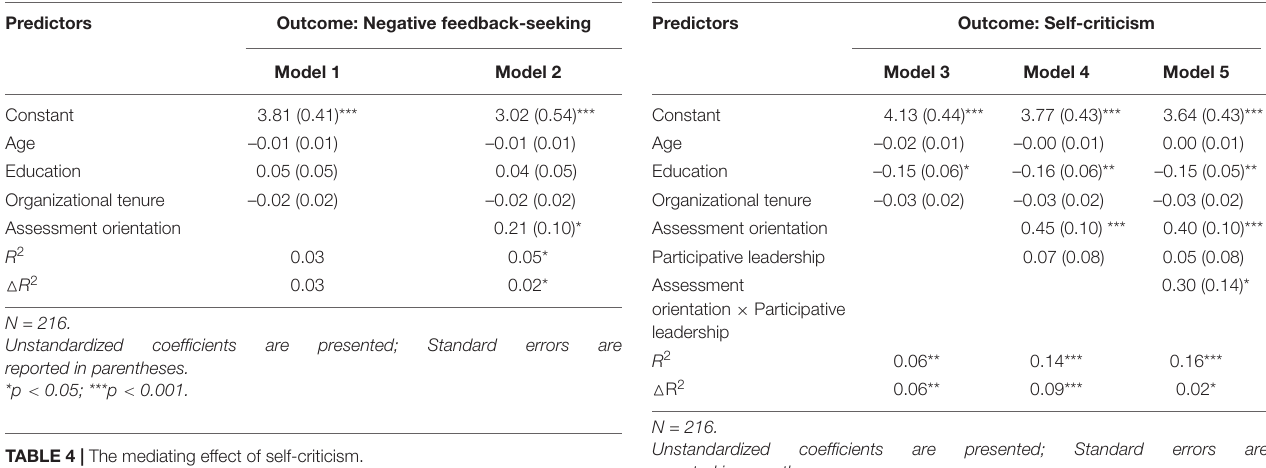
TABLE 3 | The effect of assessment orientation on negative feedback-seeking.